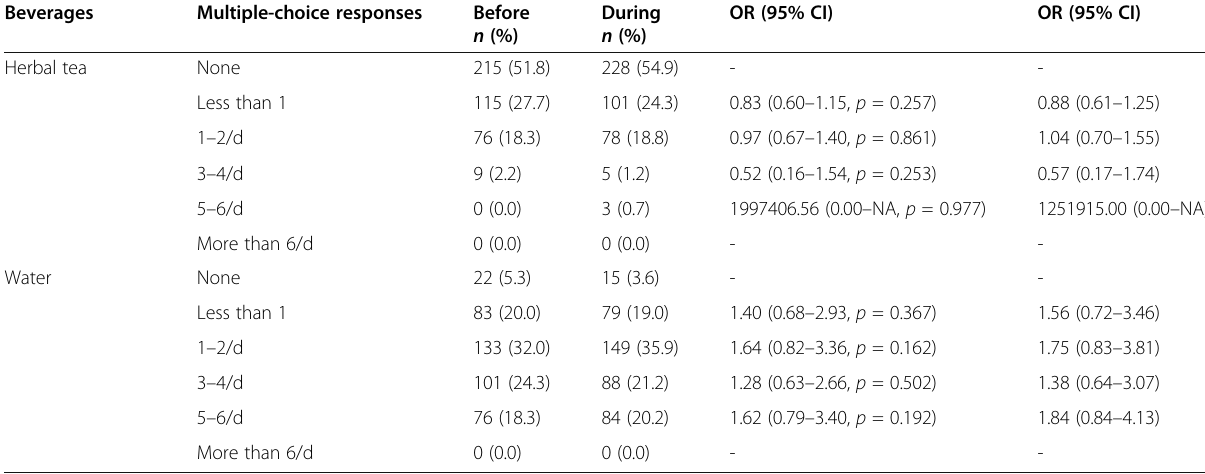
Table 4 Multivariate analysis between two periods using logistic regression for beverage consumption habits (Continued) Beverages